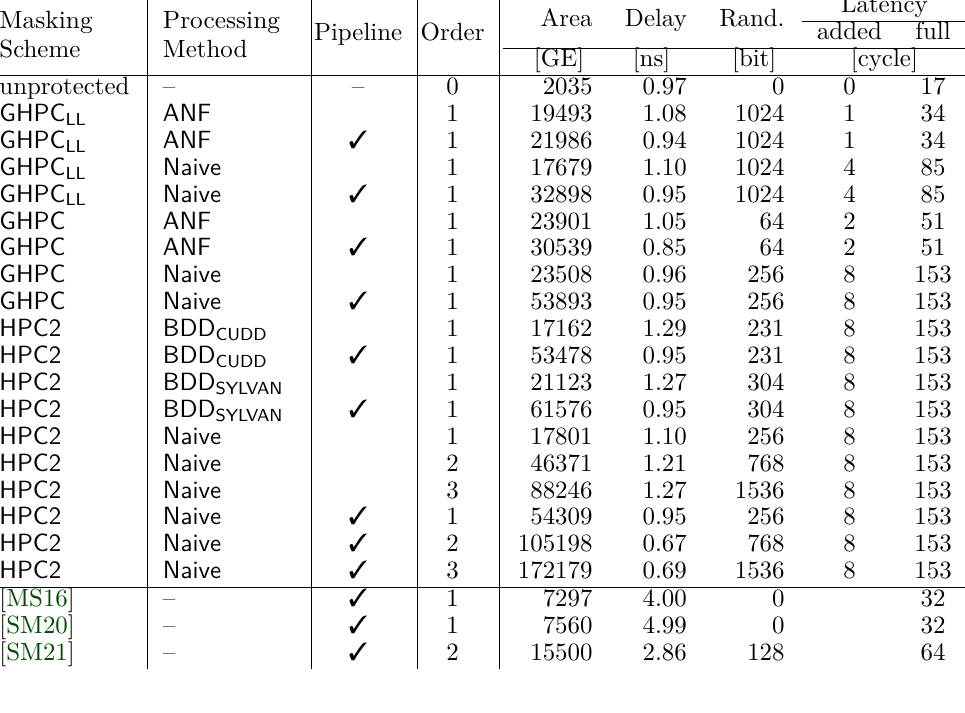
Table 14: Synthesis results, Midori-64 round-based encryption/decryption function.